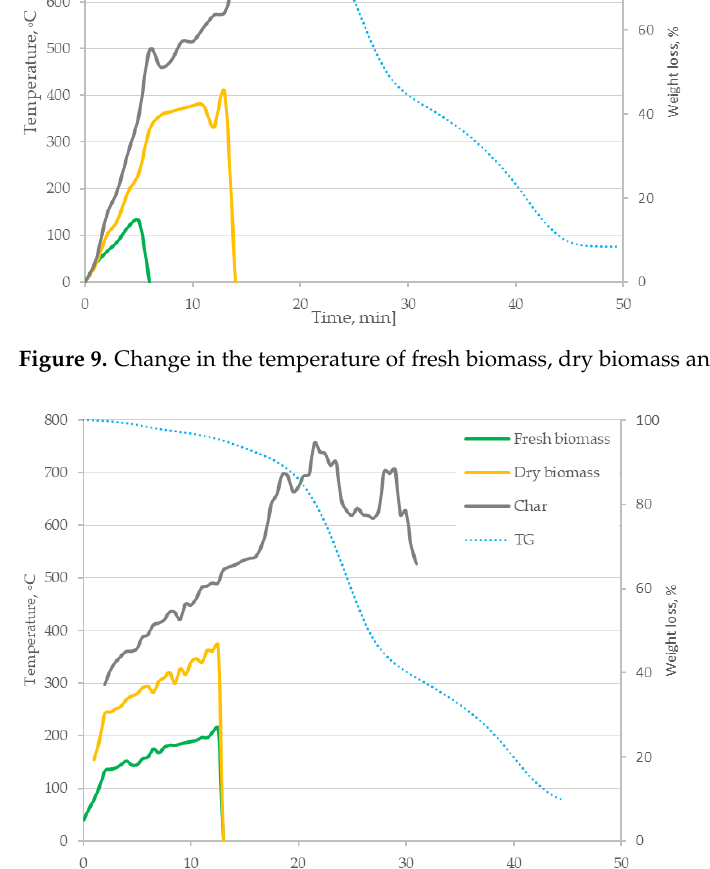
Figure 11. Change in the temperature of fresh biomass, dry biomass and char — sample 50K50J.